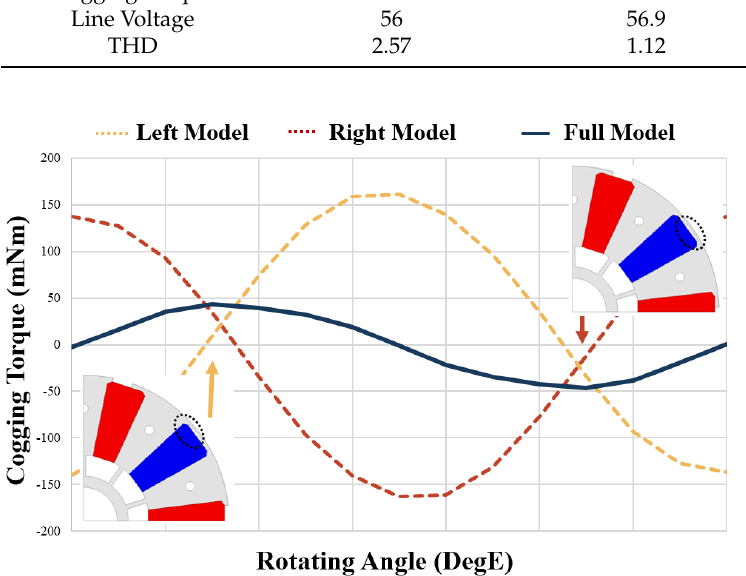
Figure 11. Cogging torque according to the asymmetric shape of the rotor barrier. Table 2. Comparison of no − load performance of the conventional spoke − type model and the pro- posed model.